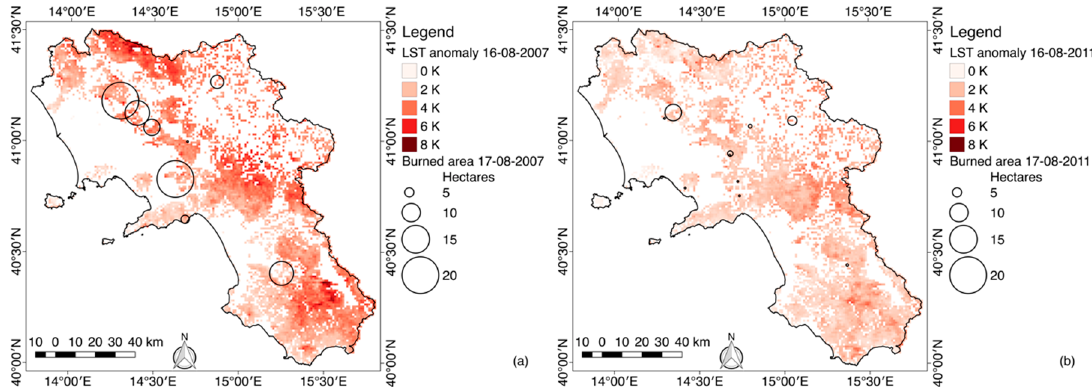
Figure 4. Land surface temperature anomaly observed in vegetated and recently burned areas (land cover classes in Table 1) on 16 August 2007 with superimposed fires recorded on 17 August 2007 ( a ) and on 16 August 2011 with superimposed fires recorded on 17 August 2011 ( b ).